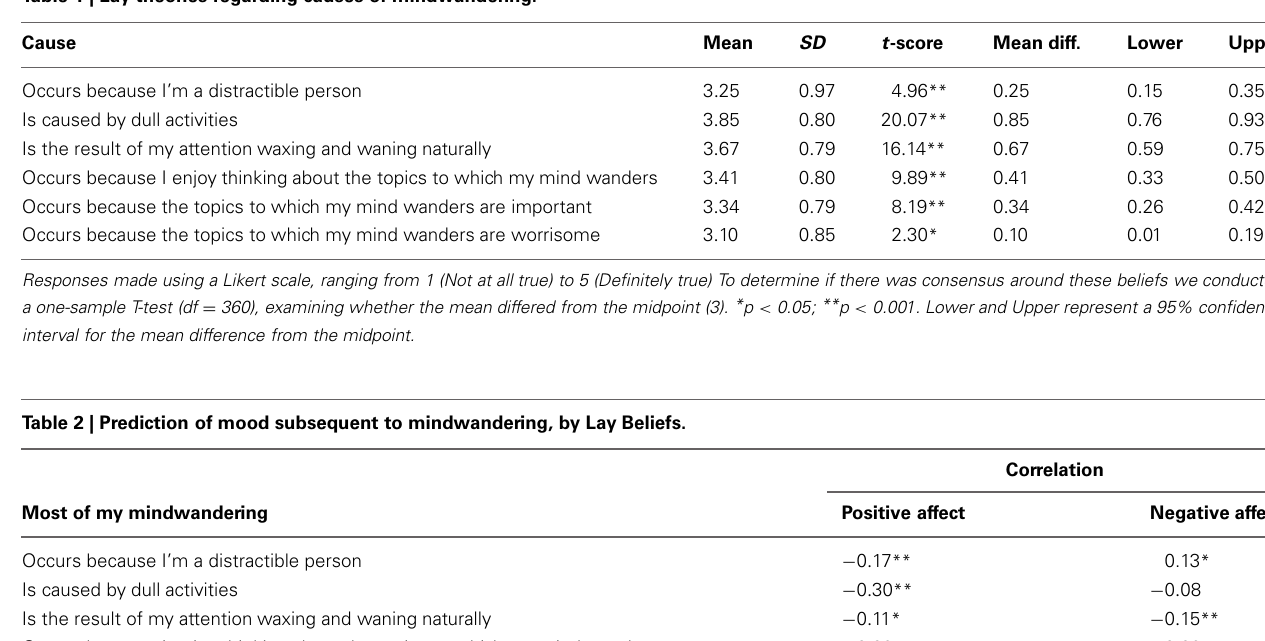
Table 1 | Lay theories regarding causes of mindwandering.